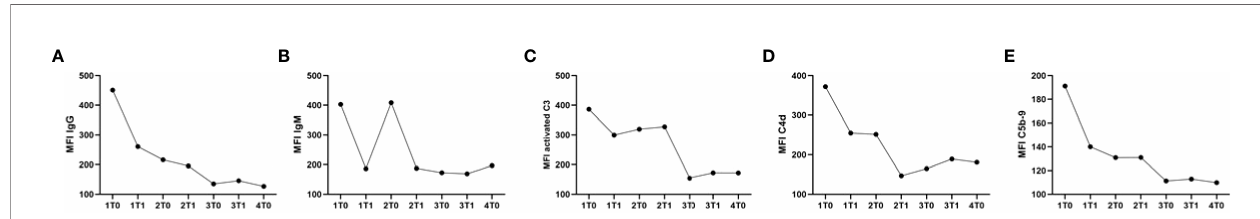
FIGURE 7 | Serum samples collected before and after plasmapheresis show a reduction in the binding of IgG, IgM, activated C3, C4d, and C5b-9 to MP-PRECs during the course of 4 cycles of plasmapheresis. Serum samples were collected right before every plasmapheresis (1, 2, 3, and 4) at the time points (T) before (0) and after (1) every plasmapheresis. (A) Binding of IgG to MP-PRECs after incubation with the patient ’ s serum collected during the course of plasmapheresis. (B) Binding of IgM to MP-PRECs after incubation with the patient ’ s serum collected during the course of plasmapheresis. (C) Binding of activated C3 to MP-PRECs after incubation with the patient ’ s serum collected during the course of plasmapheresis and 20% NHS as a complement source. (D) Binding of C4d to MP-PRECs after incubation with the patient ’ s serum collected during the course of plasmapheresis and 20% NHS as a complement source. (E) Binding of C5b-9 to MP-PRECs after incubation with the patients ’ serum collected during the course of plasmapheresis and 20% NHS as a